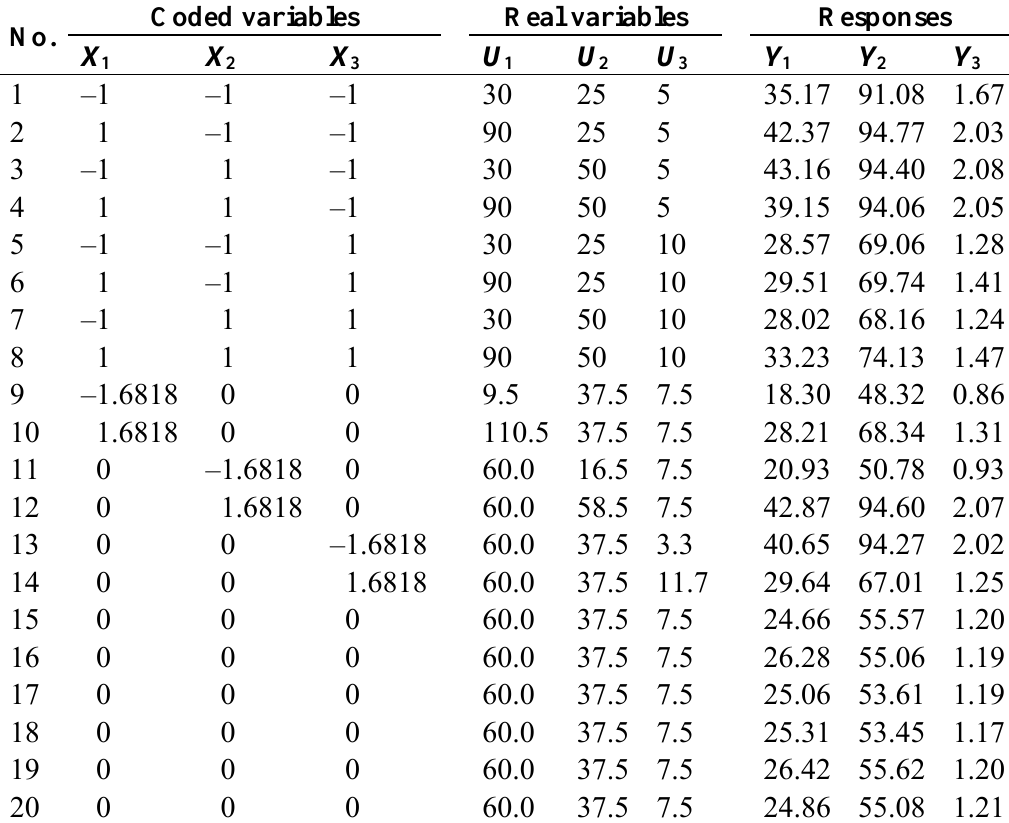
Table 2. Experimental design and results of the central composite design.